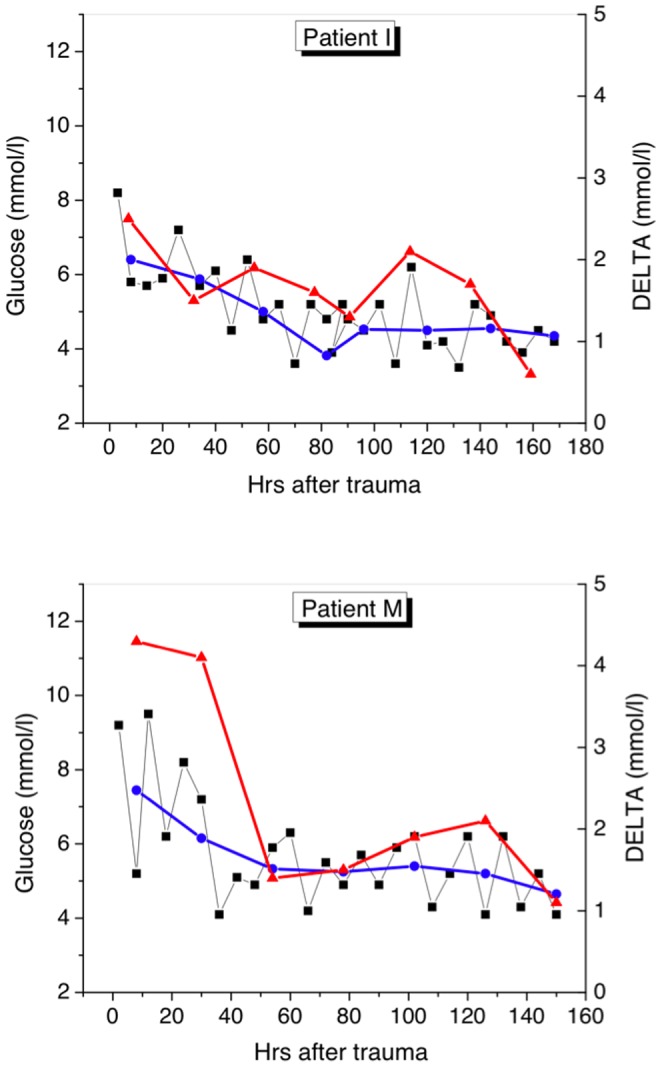
Time series of glucose measurements for patients from Group 1 (survivors without sepsis).Instant BG concentration (left axis), mean daily glucose (left axis), and daily glucose variation DELTA (right axis) are shown, respectively, by black squares, blue dots, and red triangles.